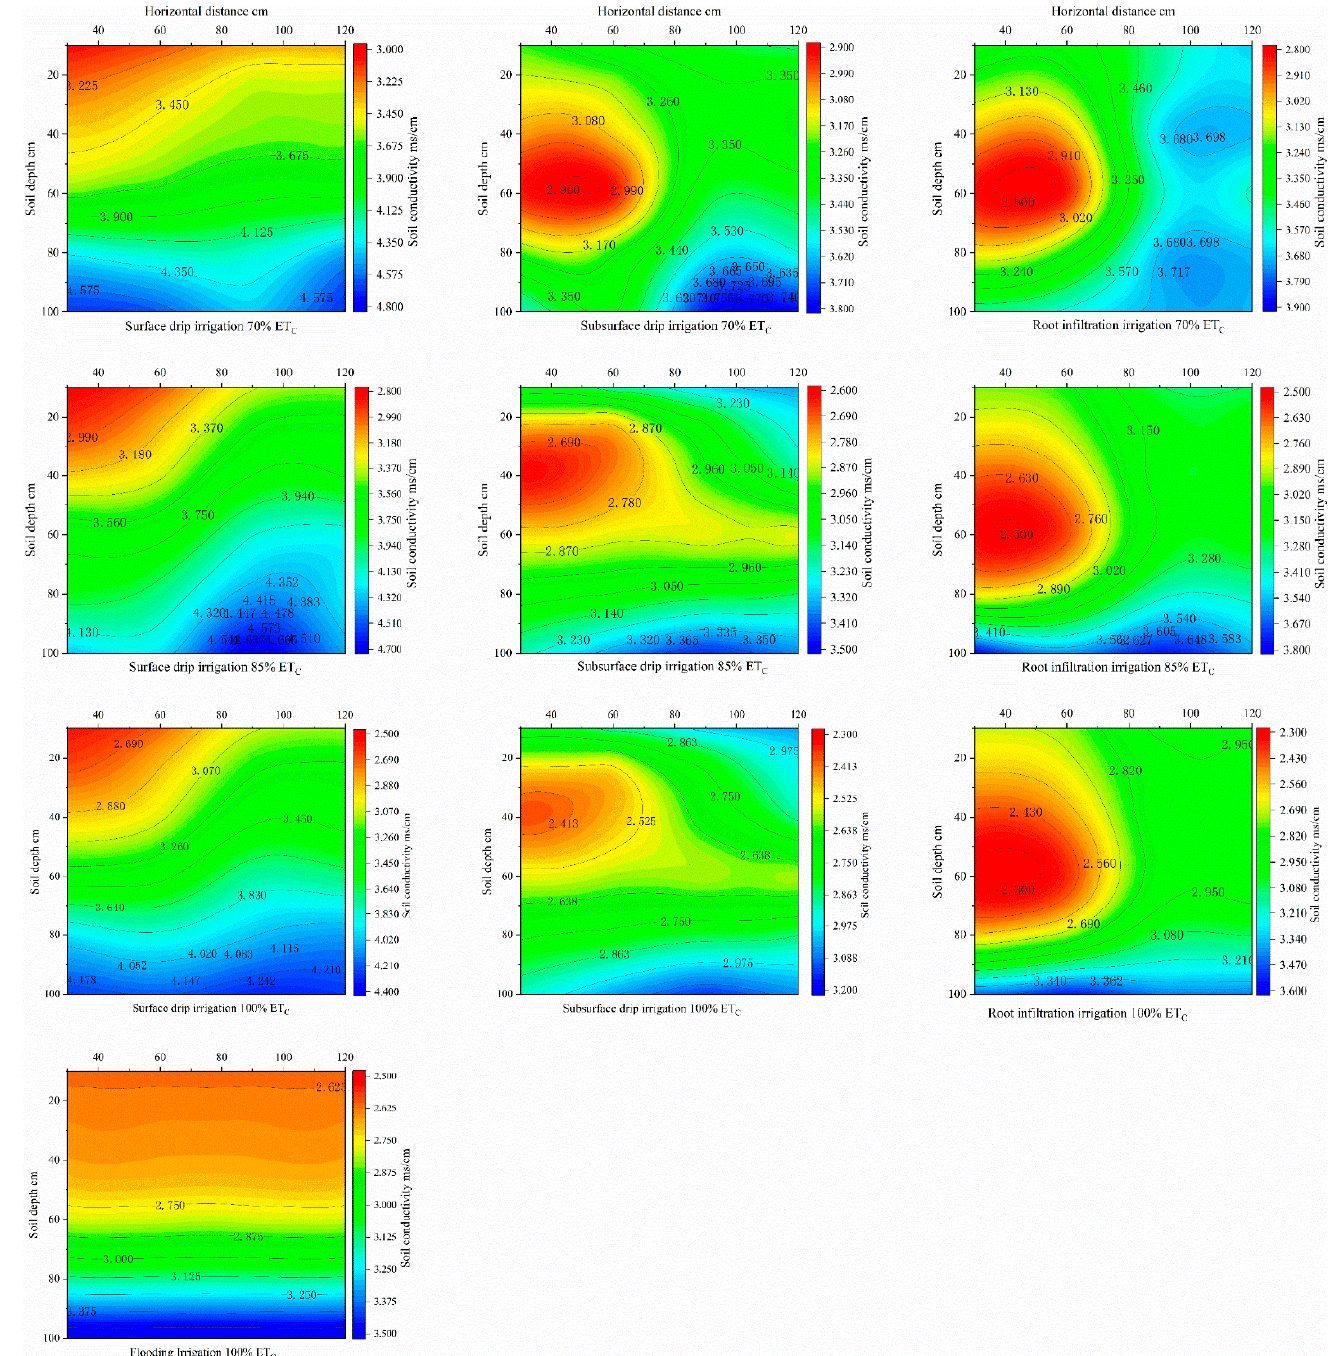
Figure 6. Changes in soil salinity (EC values) under different irrigation methods.